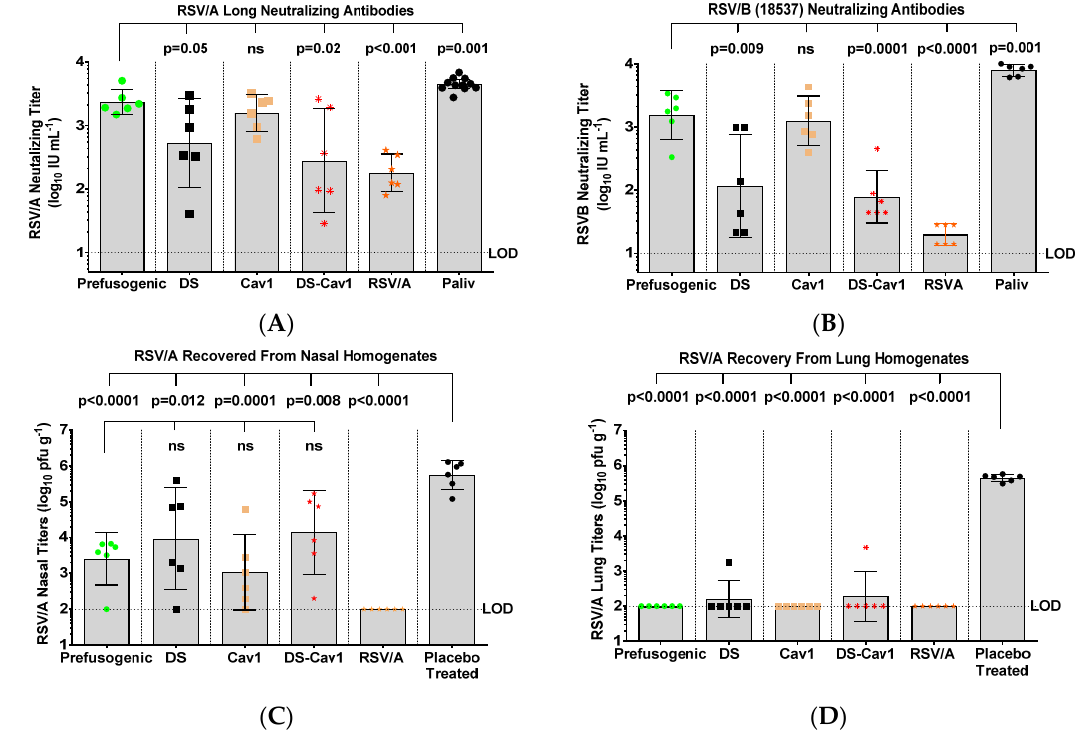
Figure 7. RSV A and B subtype neutralizing antibodies and protection against RSV challenge in cotton rats. ( A , B ) RSV A and B subtype cross-neutralizing antibody titers in animals immunized with prefusogenic F and prefusion F DS, Cav1 and DS-Cav1. ( C , D ) Nose and lung tissues were collected 4-days post-challenge (day 46) and infectious virus determined with a plaque assay. Individual animal antibody titers and virus load in nasal and lung homogenates are plotted. Symbols indicate individual animal values for each immunization group. Bars indicate the group geometric mean titer (GMT) and the error bars indicate the ± 95% CI. Statistical significance between paired groups is indicated by brackets. Limit of detection (LOD). Not significant (ns). Palivizumab